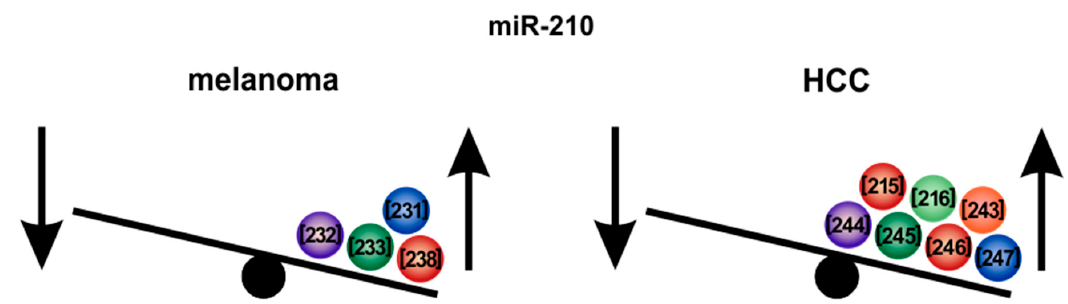
Figure8. MiR-210 isstronglyupregulatedandhasoncogenicfunctioninmelanomaandHCC.References Figure 8. MiR-210 is strongly upregulated and has oncogenic function in melanoma and HCC. (numbers in brackets indicate according references of studies) showing di ff erential expression (indicated References (numbers in brackets indicate according references of studies) showing differential by arrows) of miR-210 in melanoma and expression (indicated by arrows) of miR-210 in melanoma and HCC.